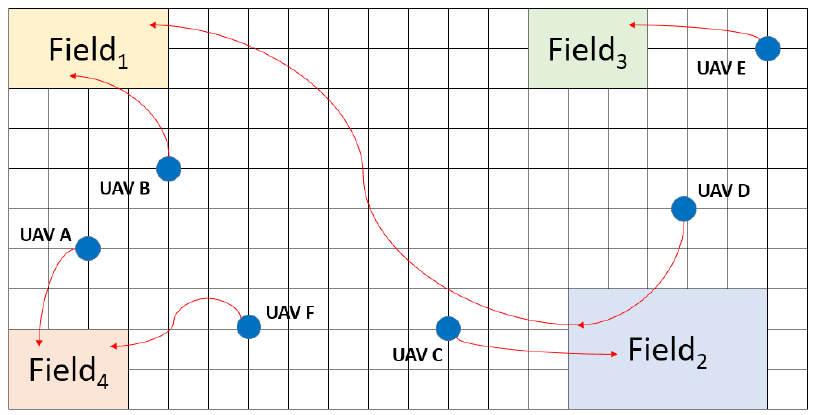
Figure 12. The result of mission decomposition and one possible mission planning strategy.